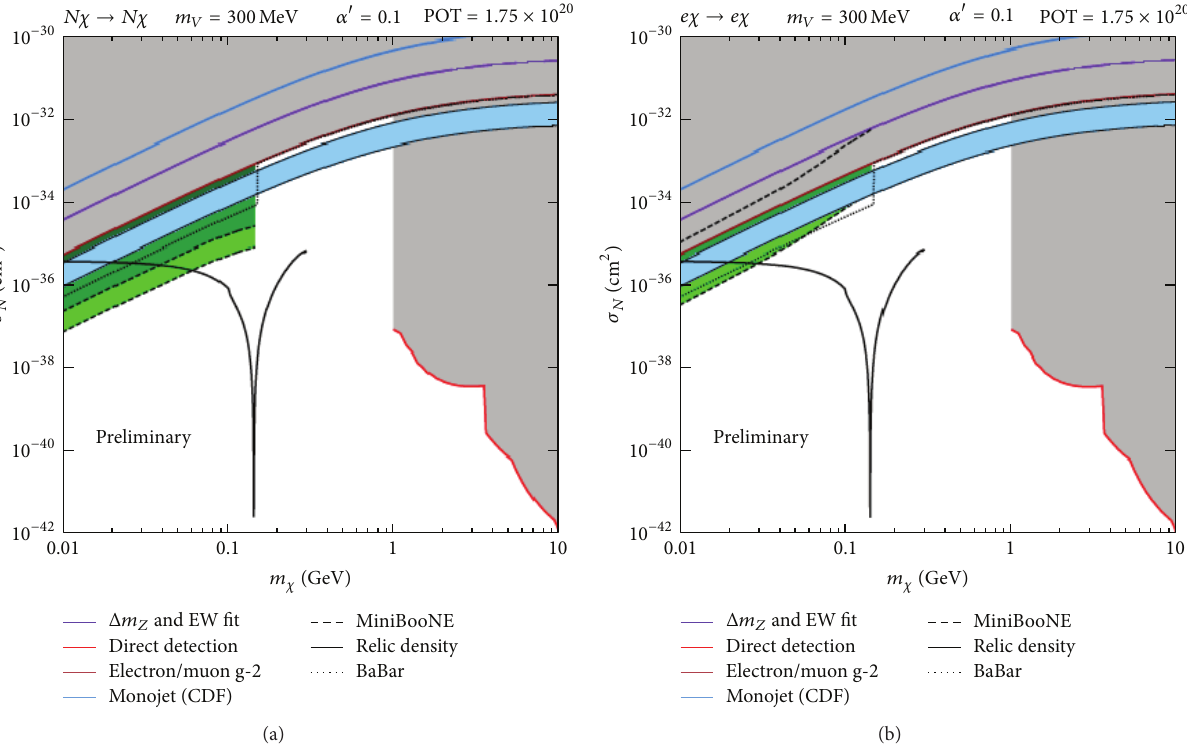
Figure 15: (color online) The MiniBooNE dark matter particles search phase space [116]. Here, the 𝑥 -axis is the dark matter mass 𝑚 𝜒 , and the 𝑦 -axis is either the dark matter-nucleon or dark matter-electron cross section, assuming the vector mediator mass and the gauge coupling ( 𝑚 𝑉 = 300 MeV and 𝛼 = 0.1 ). The MiniBooNE exclusion region can be seen in